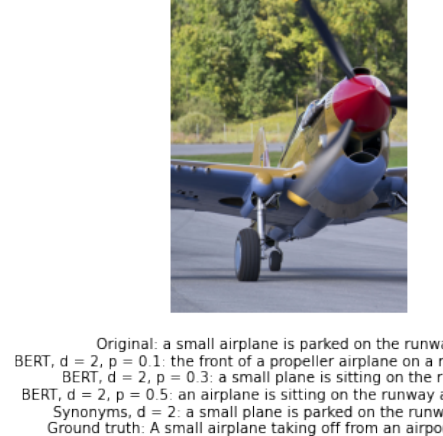
Figure 4. Examples of captions generated by the proposed models.